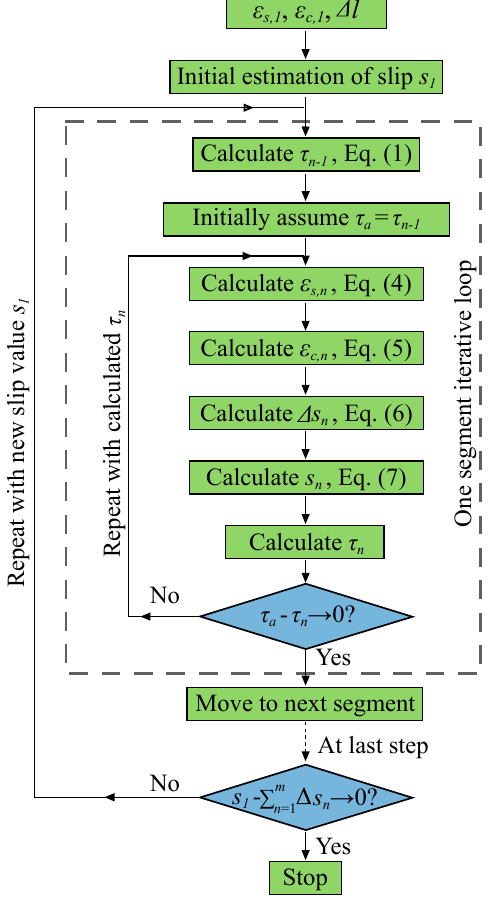
Figure 6. Flowchart of the iterative stress transfer